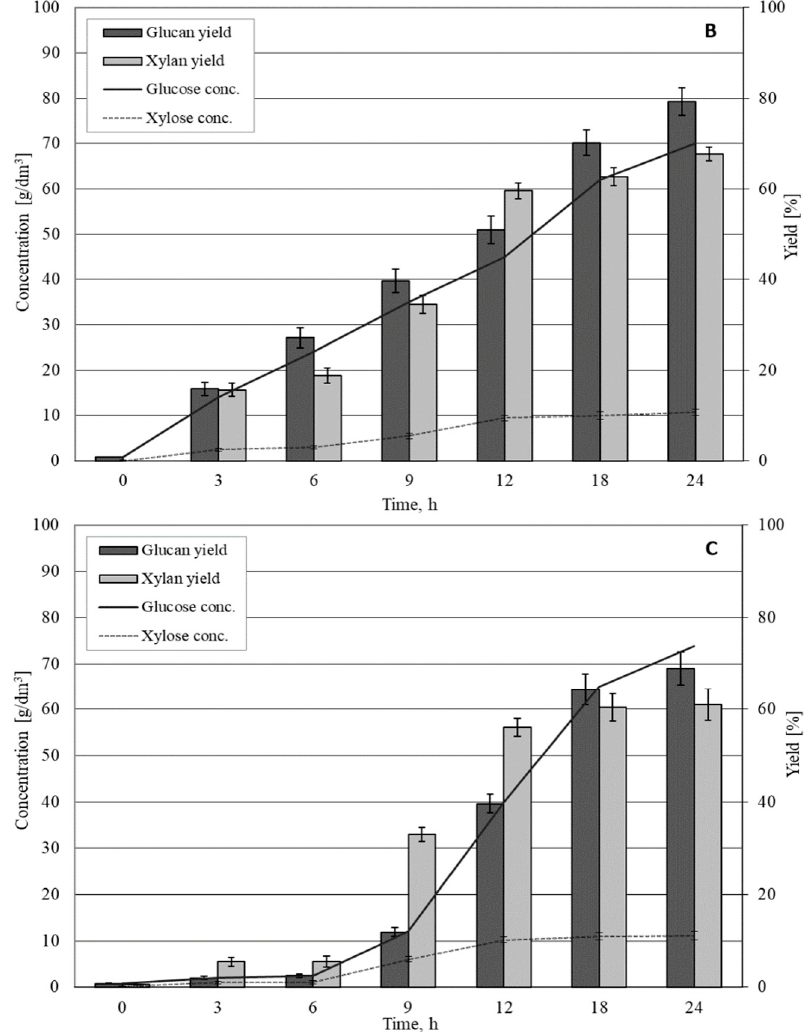
Figure 1. Selected course of enzymatic hydrolysis and obtained glucose and xylose yields (( A )—18.9% dry matter loading/wet substrate loading: 60% w / v ; ( B )—22% dry matter loading/wet substrate loading: 70% w / v /; ( C )—25% dry matter loading/wet substrate loading: 80% w / v ; error bars represent standard deviation).